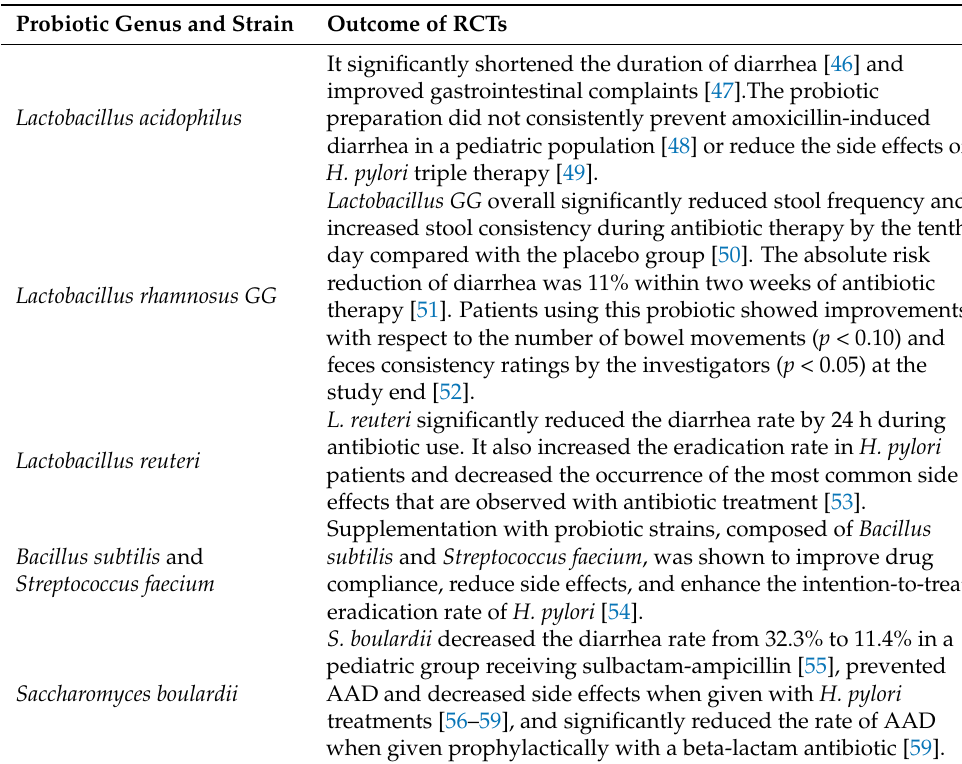
Table 1. Randomized controlled trials of probiotic use in the prevention of